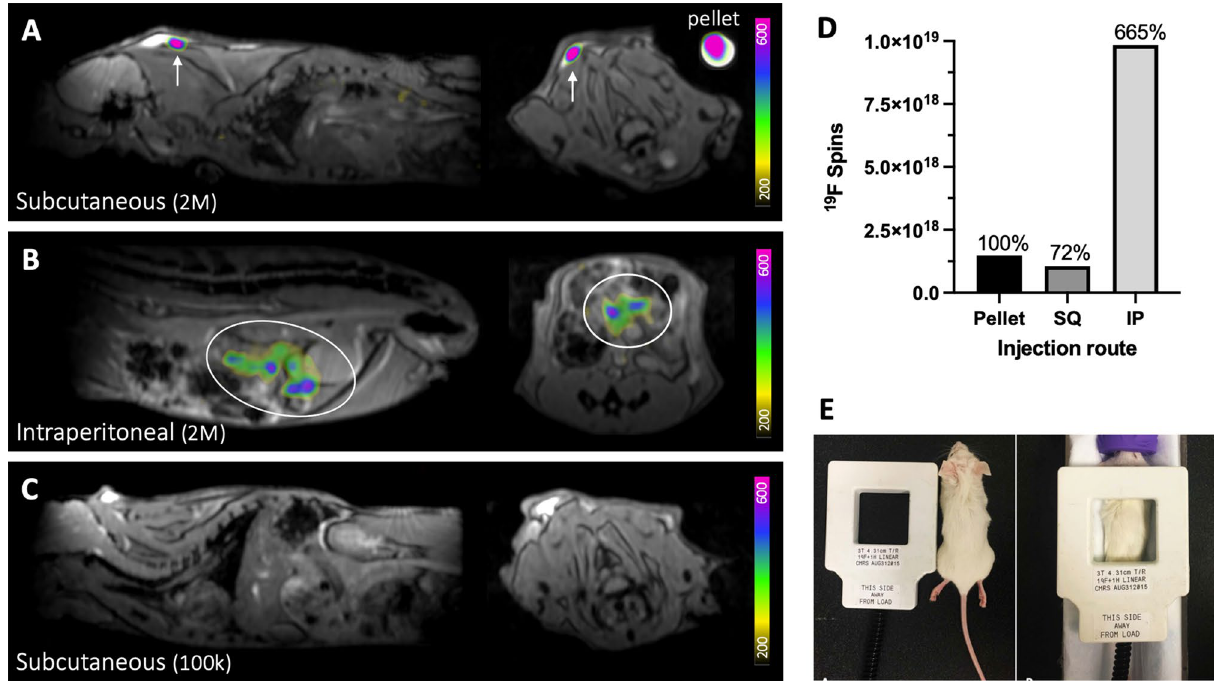
Figure 7. Detection of 2 × 10 6 PFPE-labeled MSC in vivo. 19 F signal is detected at the injection site following ( A ) subcutaneous injection (white arrows) and ( B ) intraperitoneal injection (white ovals). A cell pellet of the same cell number was imaged alongside the mouse for comparison (shown in A ). ( C ) After subcutaneous administration, 1 × 10 5 cells were undetected, as this cell number is below the detection threshold for MSC. Images are sagittal (left) and axial (right). M = million, k = thousand. ( D ) 19 F signal measured from 2 × 10 6 cells injected subcutaneous (SQ) was reduced compared to signal measured from the cell pellet, however, elevated 19 F signal was measured from cells following intraperitoneal (IP) injection. ( E ) The dual-tuned surface coil is approximately the same size as a mouse and is placed directly over the injection site for